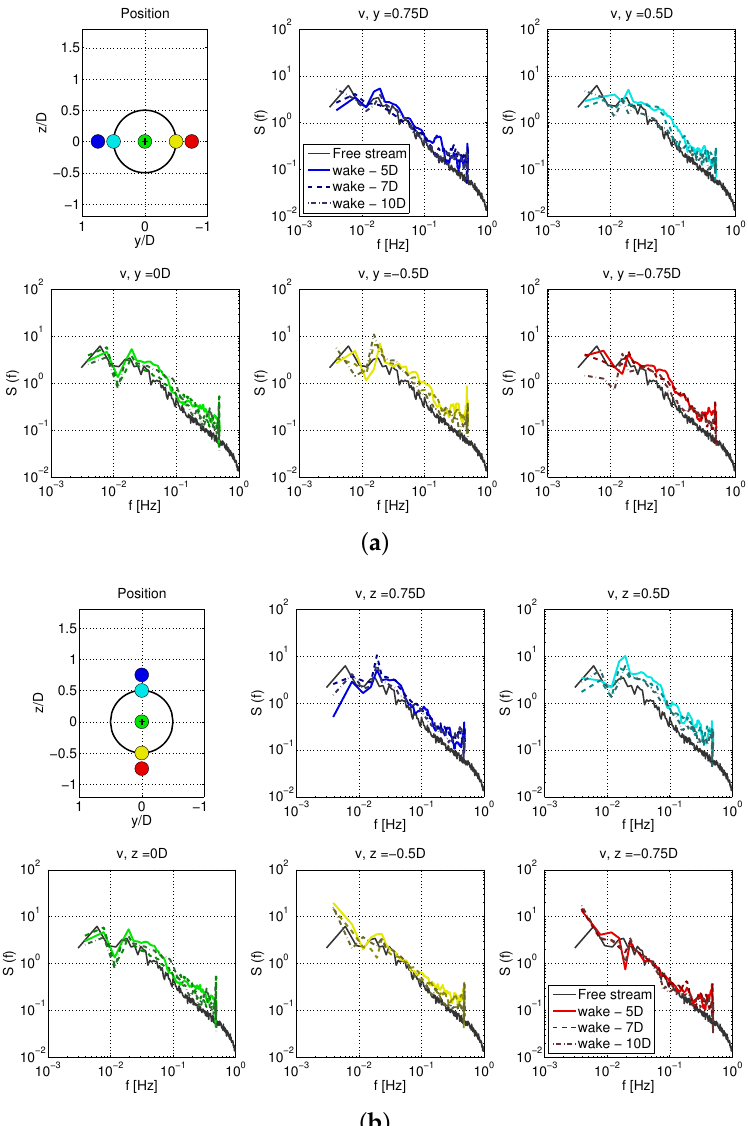
Figure 12. Power spectral density functions of v at x = 0, 5 D , 7 D , and 10 D : ( a ) lateral variation; and ( b ) vertical